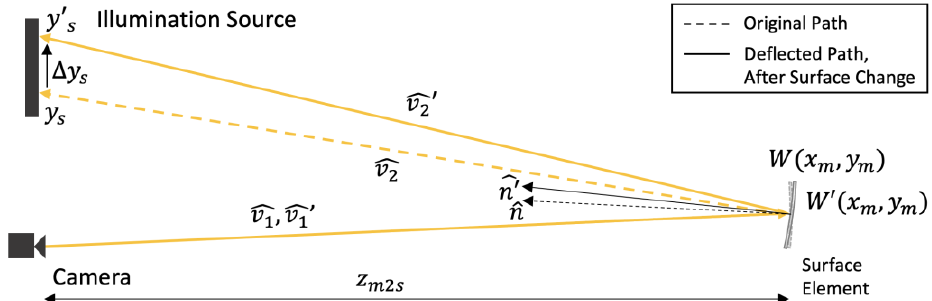
Figure 3. A unique aspect of inflatable optics is that the tensioning ring is a static datum between all varifocal states of the optic. The location of the aperture edge is stationary; only the surface slopes and height change within this circular area. Since the position of the UUT within the field of view of the camera does not change, 𝑣 1 ̂ ≅ 𝑣 1 ̂ ’. In the diagram, rays are reverse traced from the camera to UUT for a more intuitive visualization of ray slope deflection.